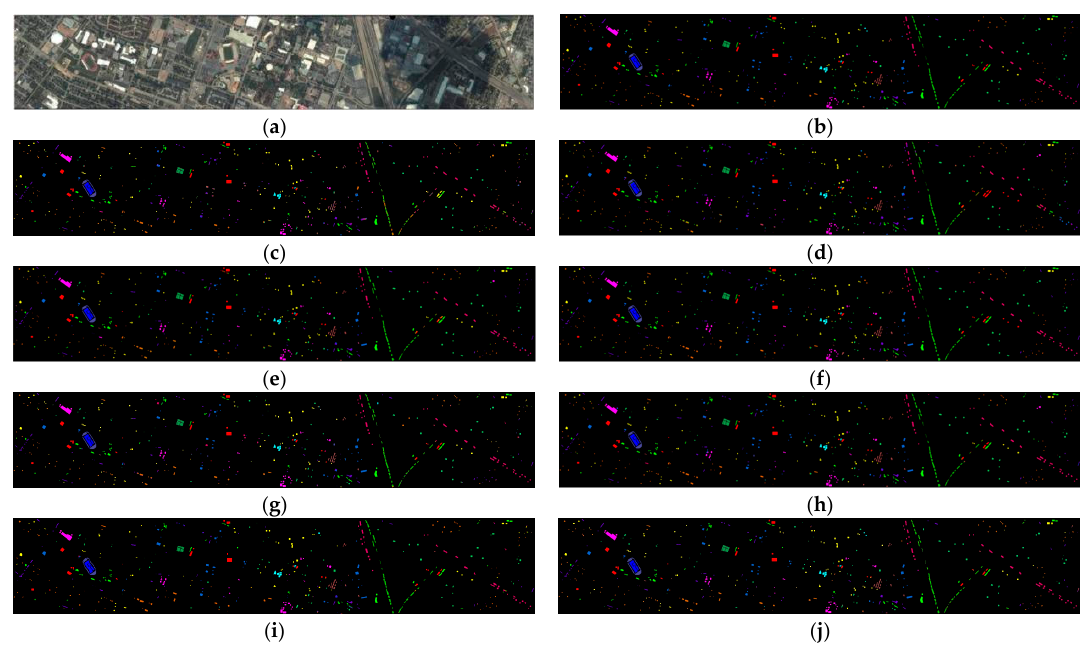
Figure 8. The classification map of Salinas. ( a ) False ‐ color image; ( b ) ground truth; ( c ) SVM; ( d ) CDCNN; ( e ) SSRN; ( f ) FDSSC; ( g ) HybirdSN; ( h ) DBMA; ( i ) MCNN; ( j ) the proposed method.